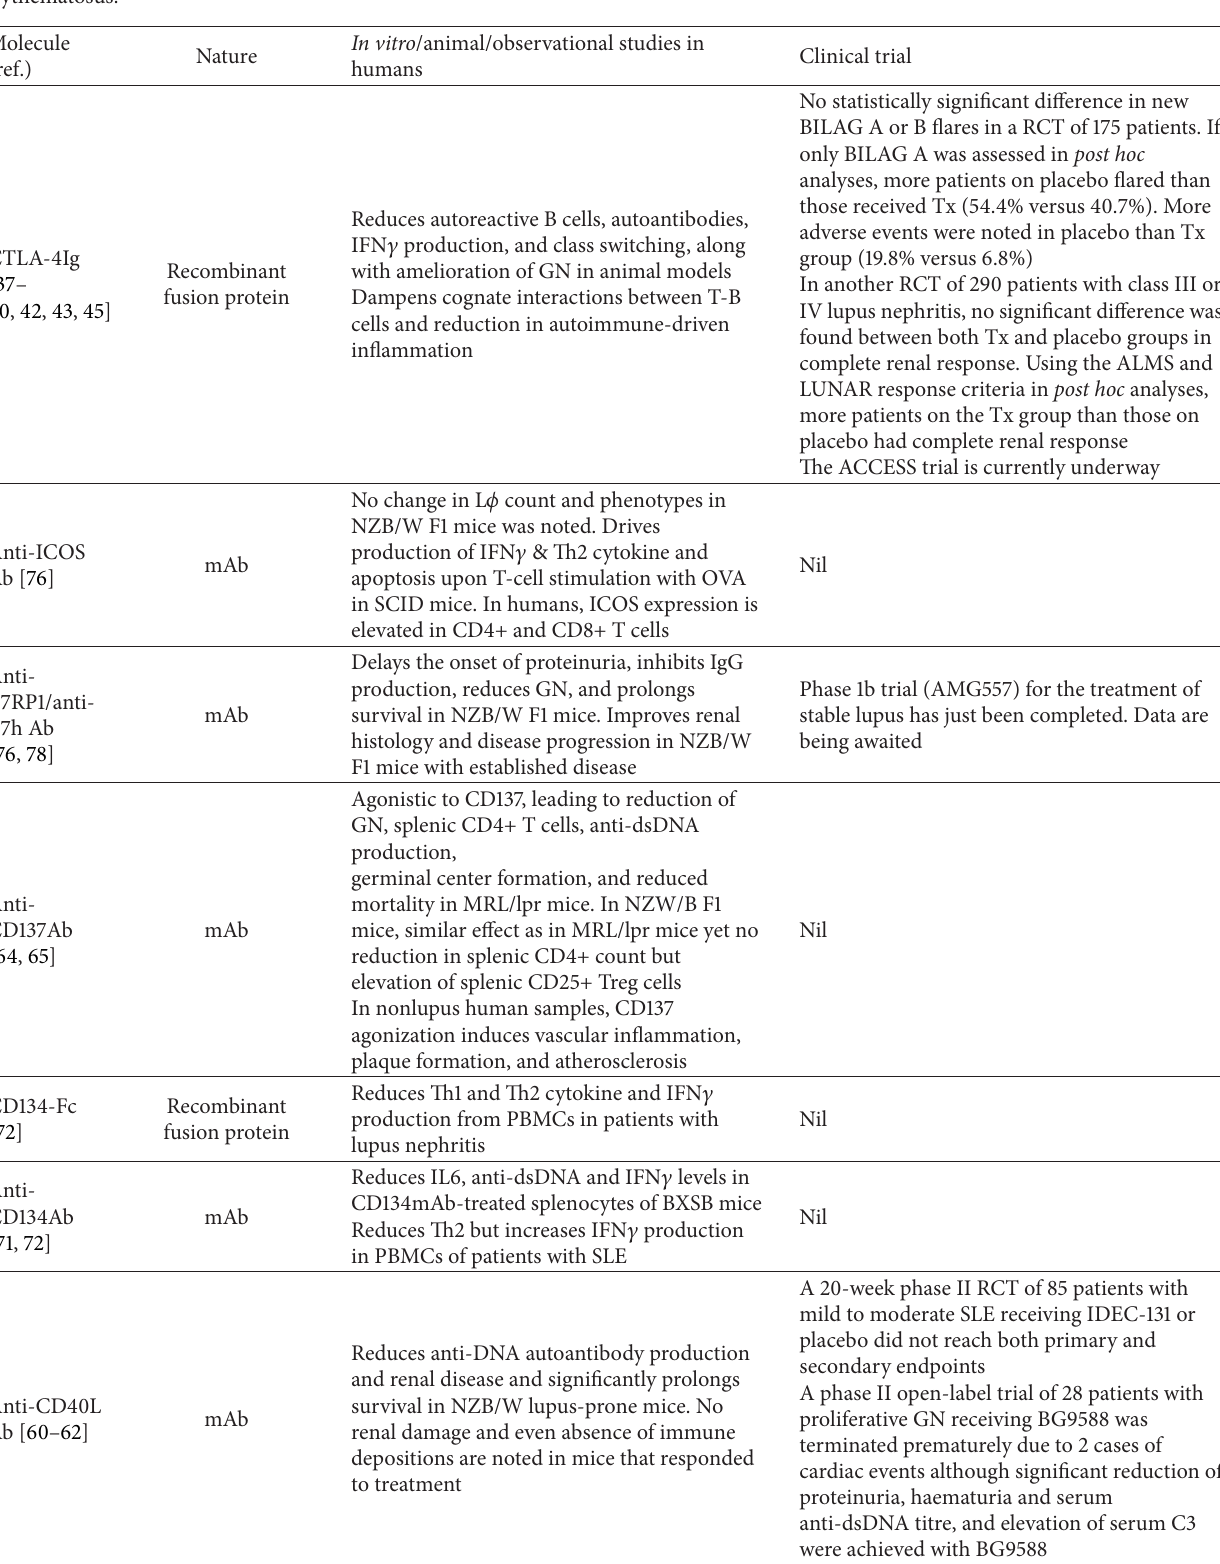
Table 2: Major translational studies and clinical trials testing various potential co-stimulatory molecules in the treatment of systemic lupus